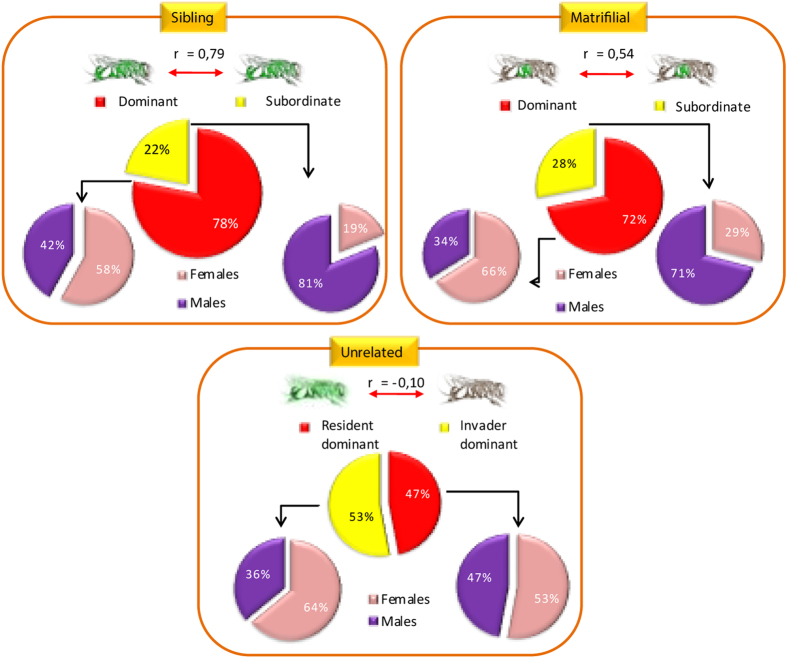
Sociogenetic structure showing the output of social contracts.The genetic relatedness between the females in each family group and the sex ratio of the offspring of these females was determined by genotyping. Dominant and subordinate females were recognized through behavioural interactions, egg laying and oophagy. Consistent with the predictions of reproductive concession regulated by dominants, dominant bees in the sibling nests reared 34 females and 25 males (a) χ21 = 1.373, p > 0.05), while subordinate sisters raised mainly males (9 females to 11 males; χ21 = 4.45, p < 0.05). In matrifilial nests, dominants invested in a female-biased reproductive sex ratio (b) 36 females to 19 males, χ21 = 5.25, p < 0.05), whereas their daughters produced a male-biased ratio (6 females to 15 males; χ21 = 5.76, p < 0.05). The overall reproductive output of matrifilial nests was 42 females to 34 males, which does not deviate significantly from a 1:1 ratio (χ21 = 0.02 p > 0.05). In unrelated associations, on the other hand, reproductive output was more evenly balanced (62 females to 50 males), with invaders producing 32 females and 23 males (c) χ21 = 1.47, p > 0.05) and dominant resident bees, 30 females and 27 males (χ21 = 0.15, p > 0.05).